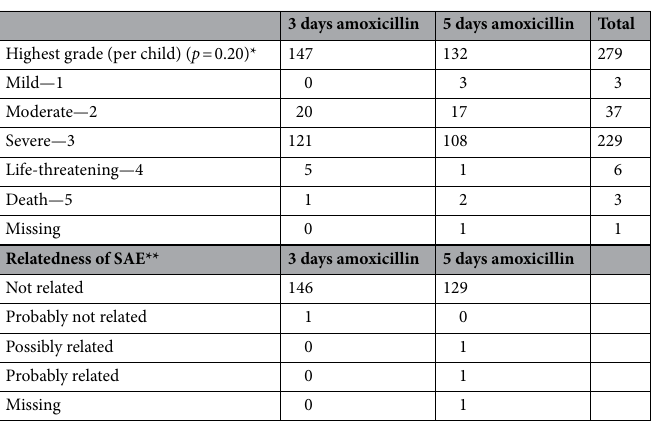
Table 3. Characteristics of serious adverse events (SAEs) by treatment group. *Based on Fisher’s exact test. **No formal testing done because of small numbers.